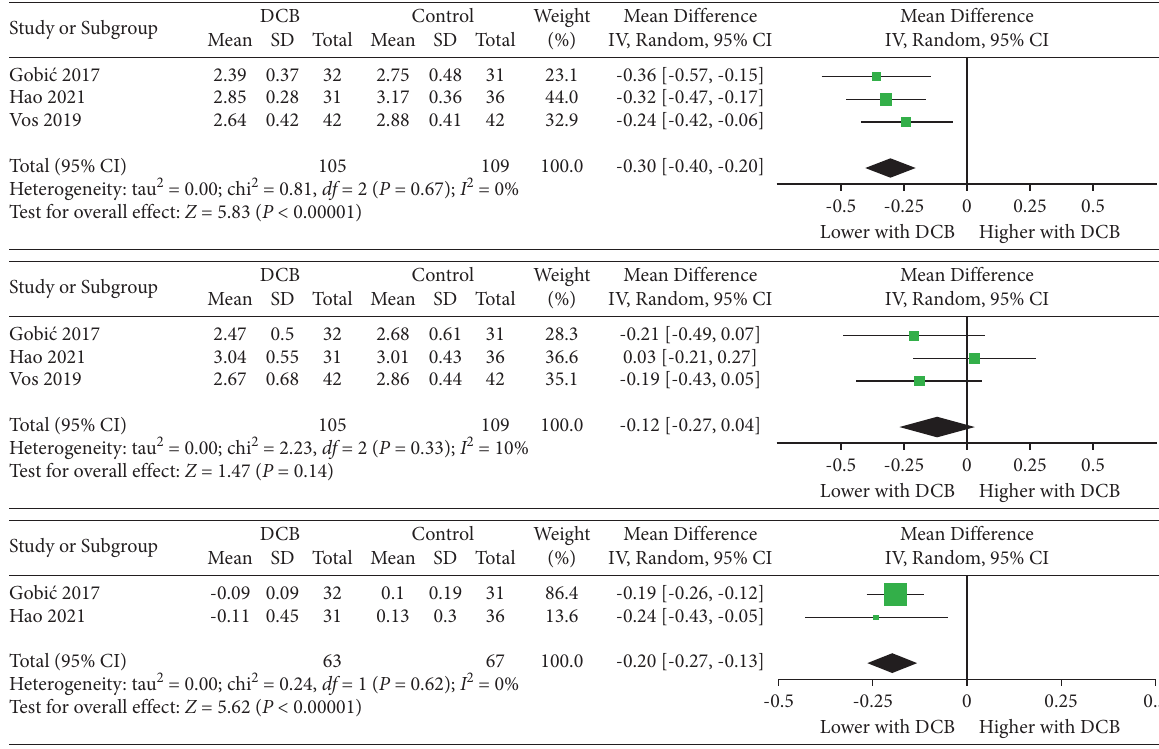
Figure 3: Summary plots for the angiographic outcomes. Mean diference of minimum lumen diameter after the index procedure (a), minimum lumen diameter at the follow-up angiograph (b), and late lumen loss (c). Te relative size of the data markers indicates weight of sample size from each study. DCB: drug-coated balloon; DES: drug-eluting stent; BMS: bare-metal